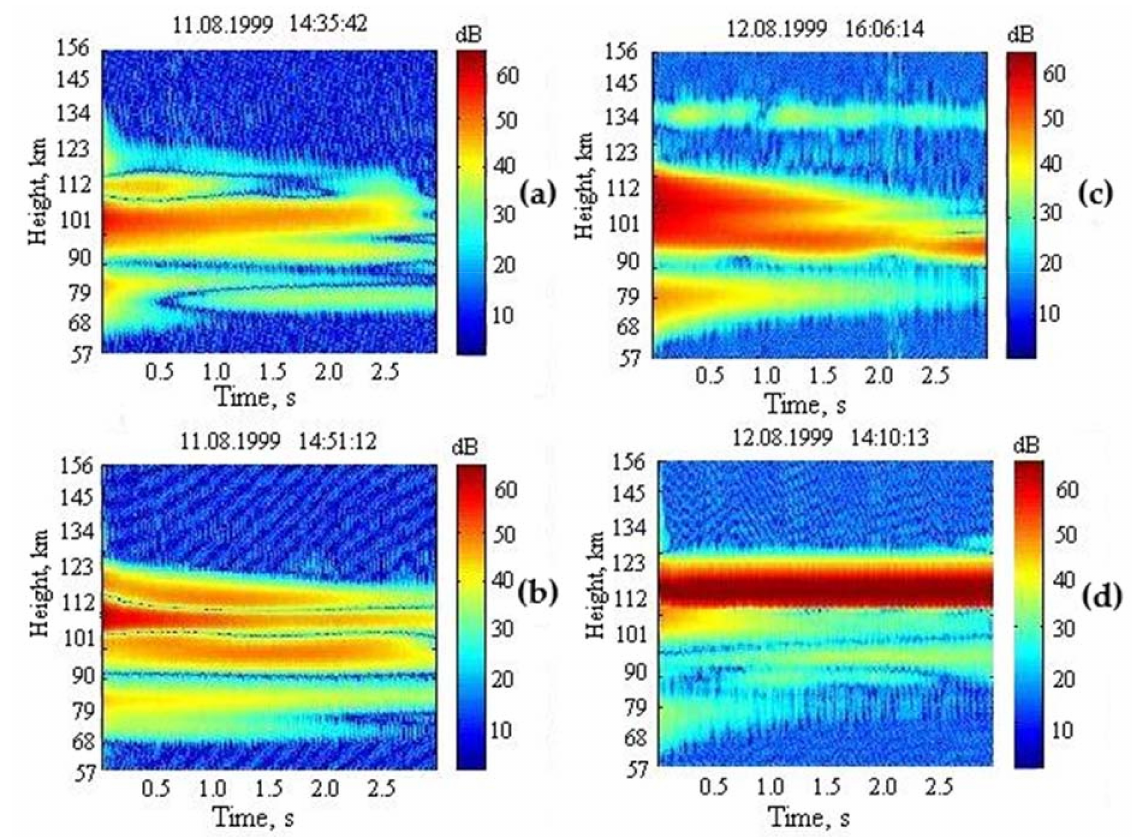
Figure 6. Time-height-amplitude plot of the API scattered signal, including the period of the solar eclipse on 11 August 1999 ( a , b ) and the next day 12 August 1999 ( c , d ). These are examples of the complex structure of the E region and the stratification of the sporadic E